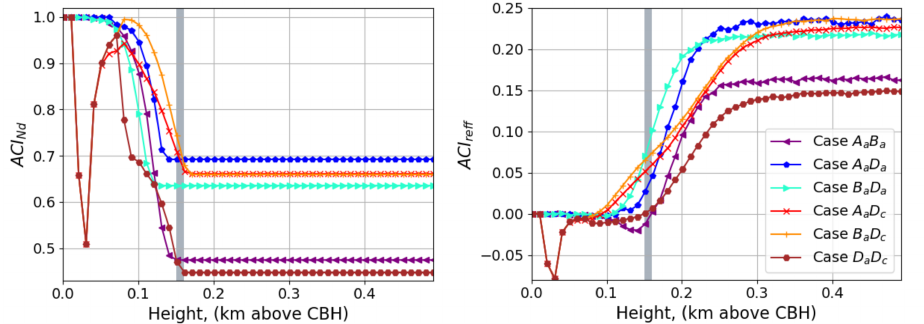
Figure 10. Aerosol cloud interaction index ( ACI Nd and ACI ref f ) for different mixtures of two aerosol types, as a function of height, according to the